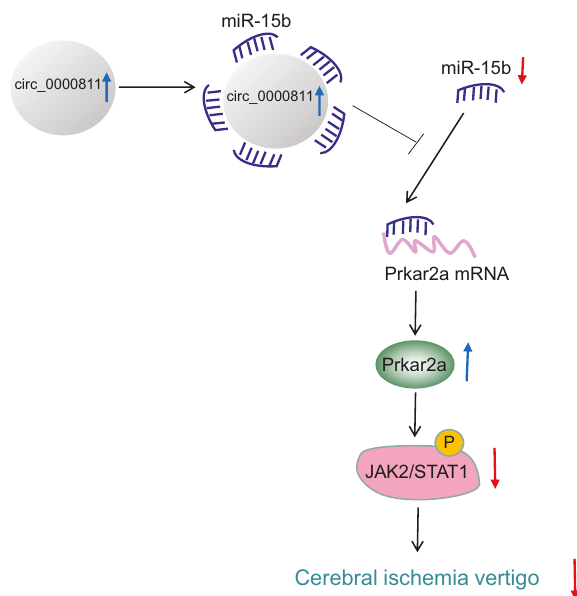
Fig. 7 The mechanism graph of the regulatory role of circ_0000811 in cerebral ischemic vertigo. Circ_0000811 upregu- lates Prkar2a and inactivates the JAK2/STAT1 axis through competi- tively binding to miR-15b and thus ameliorates cerebral ischemic